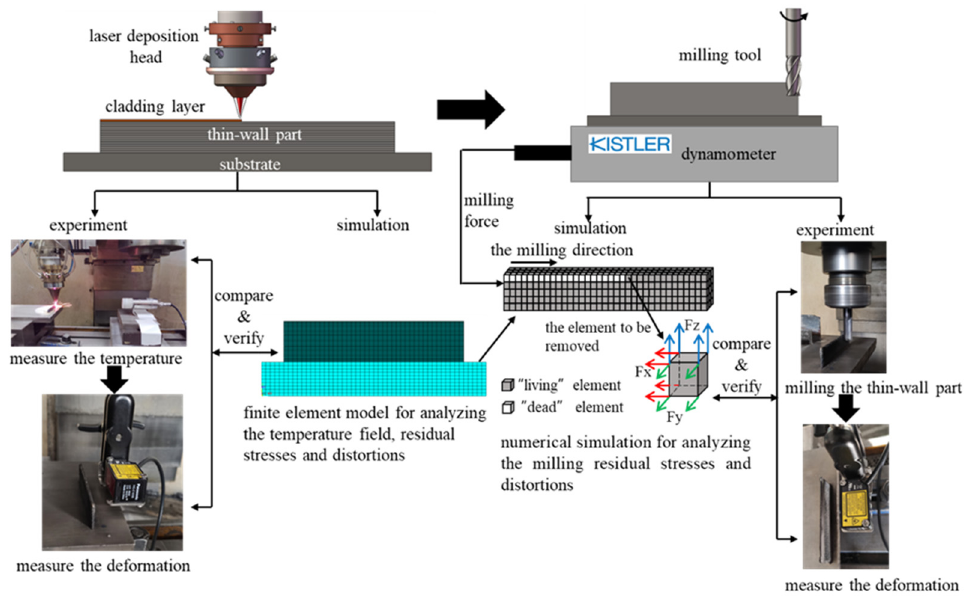
Figure 1. The research content structure of this paper.